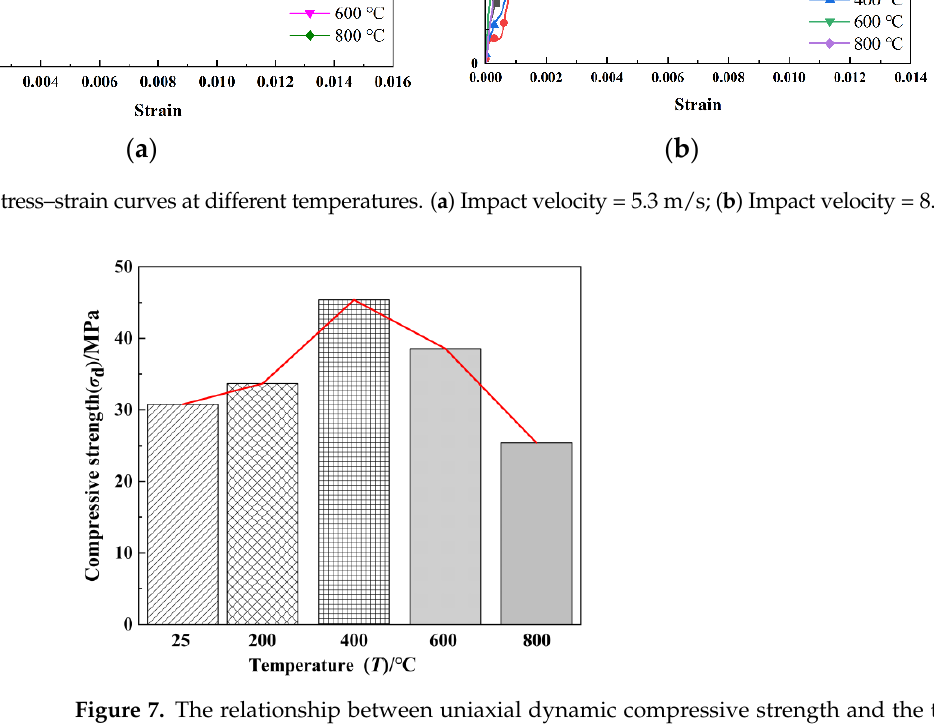
Figure 6. Dynamic stress–strain curves at different temperatures. ( a ) Impact velocity = 5.3 m/s; ( b ) Impact velocity = 8.6 m/s